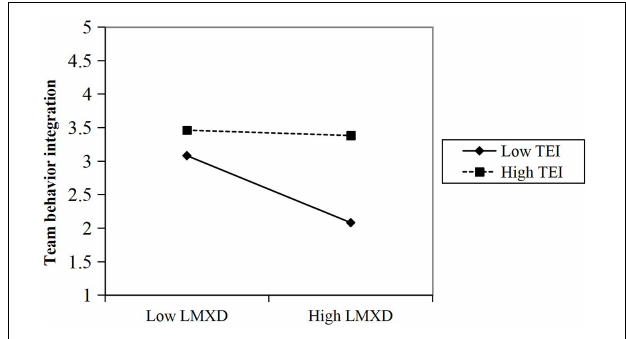
FIGURE 2 | Interaction